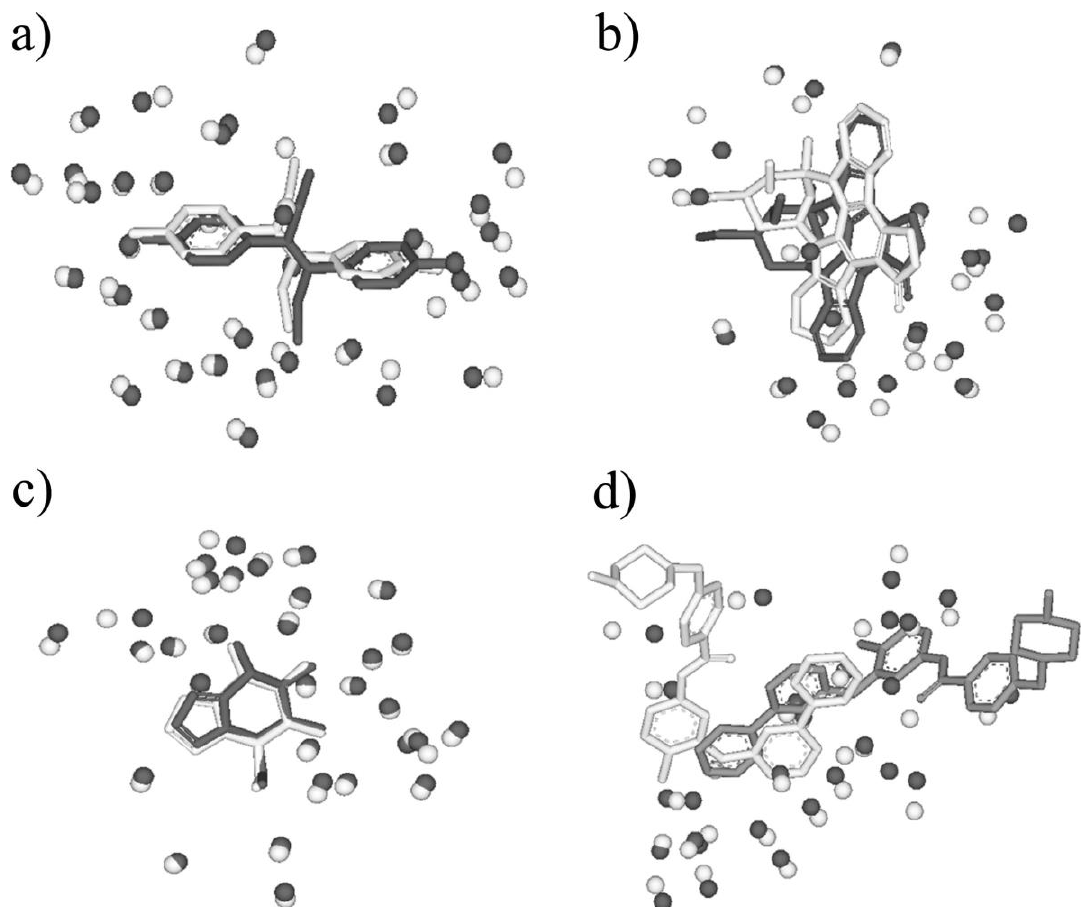
Figure 3. ( a ) The matched binding sites for Diethylstilbestrol between ERRγ (in white, PDB entry: 1S9P) and ER α (in black, PDB entry: 3ERD) by BSMM (Sequence Identity: 32%, Mscore: 0.875); ( b ) the matched binding sites for Staurosporine between CDK2 (in white, PDB entry: 1AQ1) and EGFR (in black, PDB entry: 2ITQ) by BSMM (Sequence Identity: 19%, Mscore: 0.811); ( c ) the matched binding sites for Glucoimidazole between Beta-galactosidase (in white, PDB entry: 2CEQ) and Beta-glucosidase (in black, PDB entry: 2CES) by BSMM (Sequence Identity: 28%, Mscore: 0.969). ( d ) the matched binding sites for imatinib between c-Kit (in white, PDB entry: 1T46) and Syk (in black, PDB entry: 2XBB) by BSMM (Sequence Identity: 32%, Mscore: 0.649).